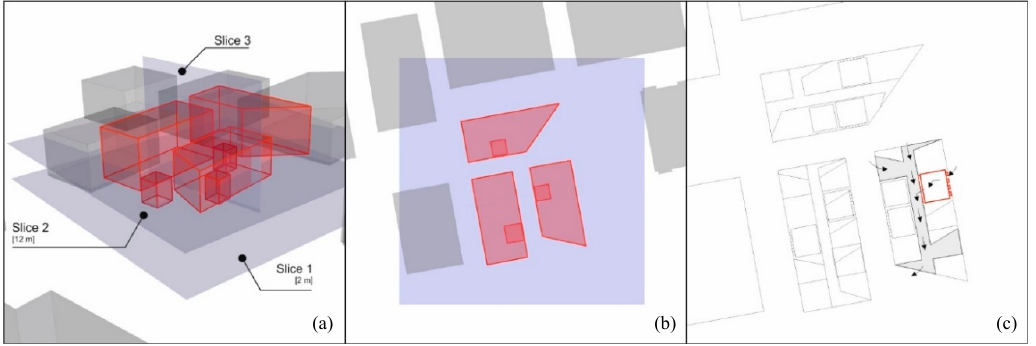
Figure 2. ( a ) Massing of the proposed faculty building showing the investigation slices; ( b ) top view; ( c ) sample classroom in the eastern wing.